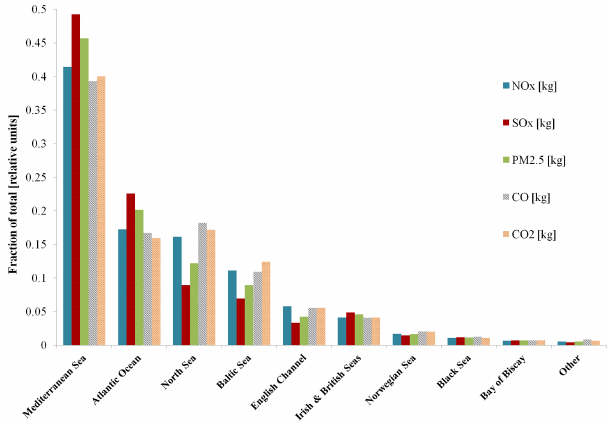
Figure 4. The fractions of shipping emissions for European sea re- gions in